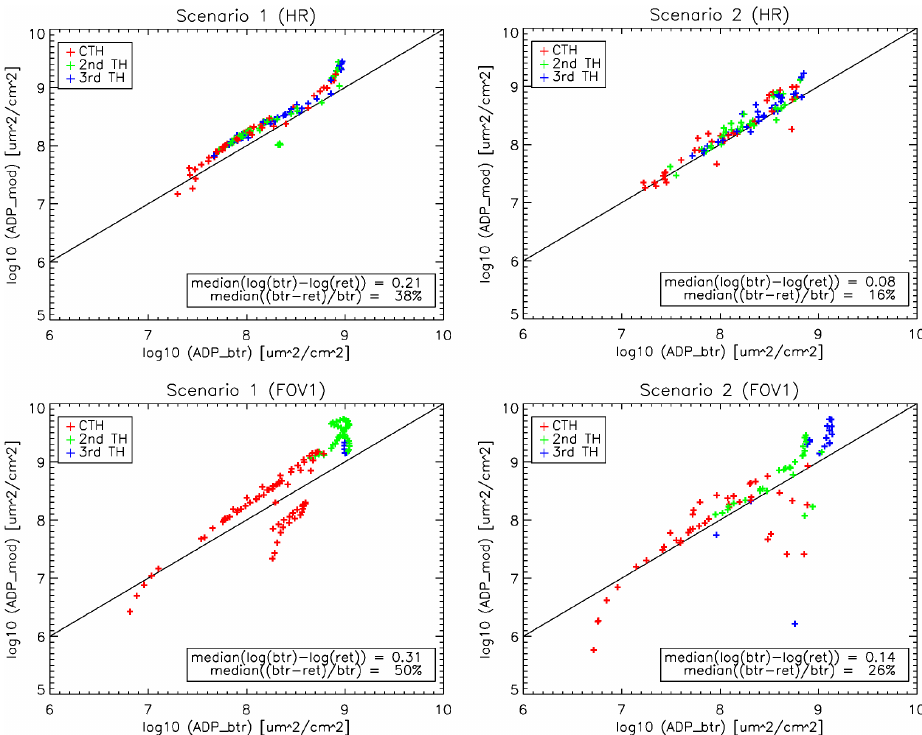
Fig. 11. Retrieved ADP versus “true state” ADP values at the detected CTH in blind test data fields for Scenario 1 and 2 (left/right). Top figures show the high-resolution (HR) and the bottom figures the FOV convolution